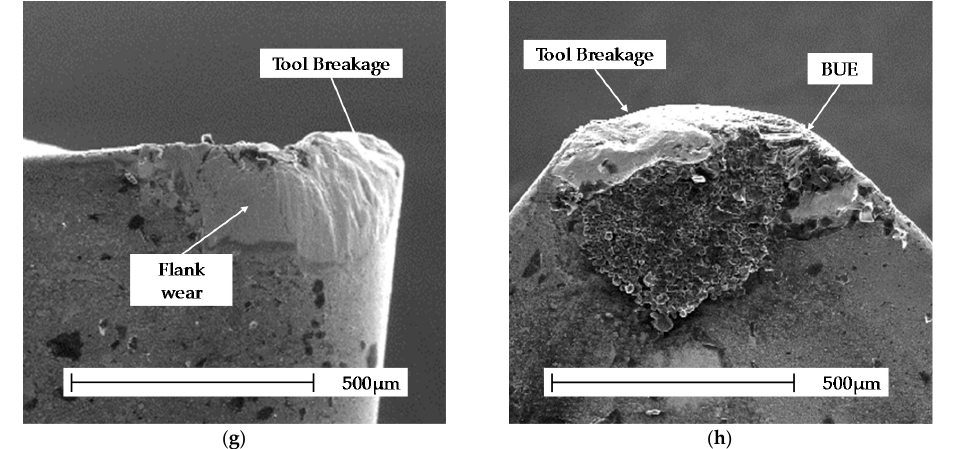
Figure 4. SEM images of the tool, for different cutting parameters, at the end of the tool life. Cutting speed of 50 m/min and feed of 0.1 mm/rev: ( a ) relief surface view; ( b ) rake surface view. Cutting speed of 50 m/min and feed of 0.15 mm/rev: ( c ) relief surface view; ( d ) rake surface view. Cutting speed of 90 m/min and feed of 0.1 mm/rev: ( e ) relief surface view; ( f ) rake surface view. Cutting speed of 90 m/min and feed of 0.15 mm/rev: ( g ) relief surface view; ( h ) rake surface view. The tool life for the range of cutting parameters considered in this work ranged from 3.9 min to